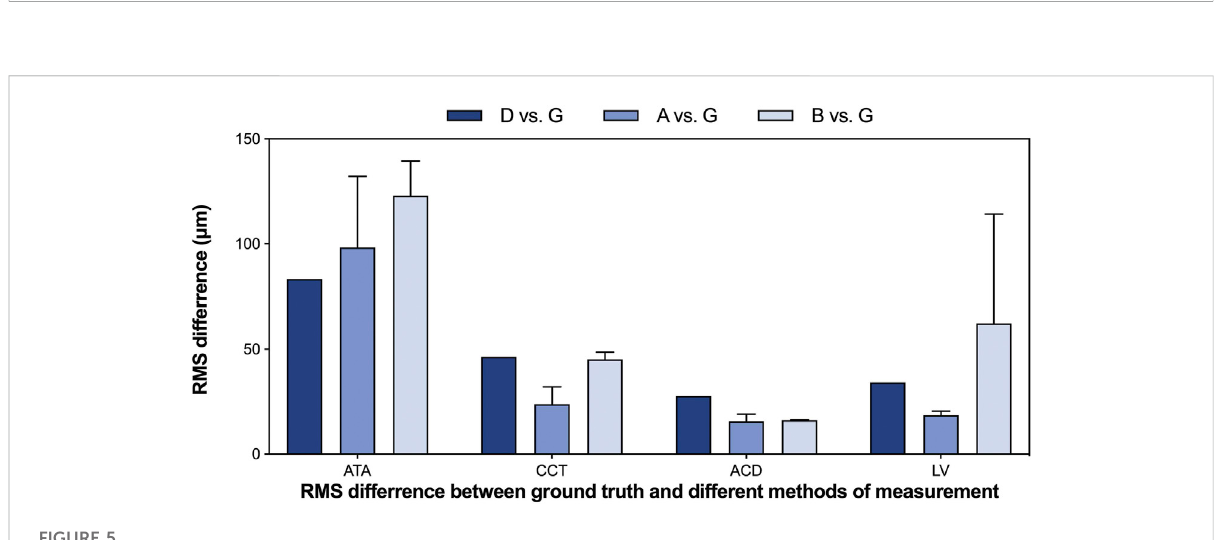
FIGURE 5 The RMS difference between ground truth and different methods of